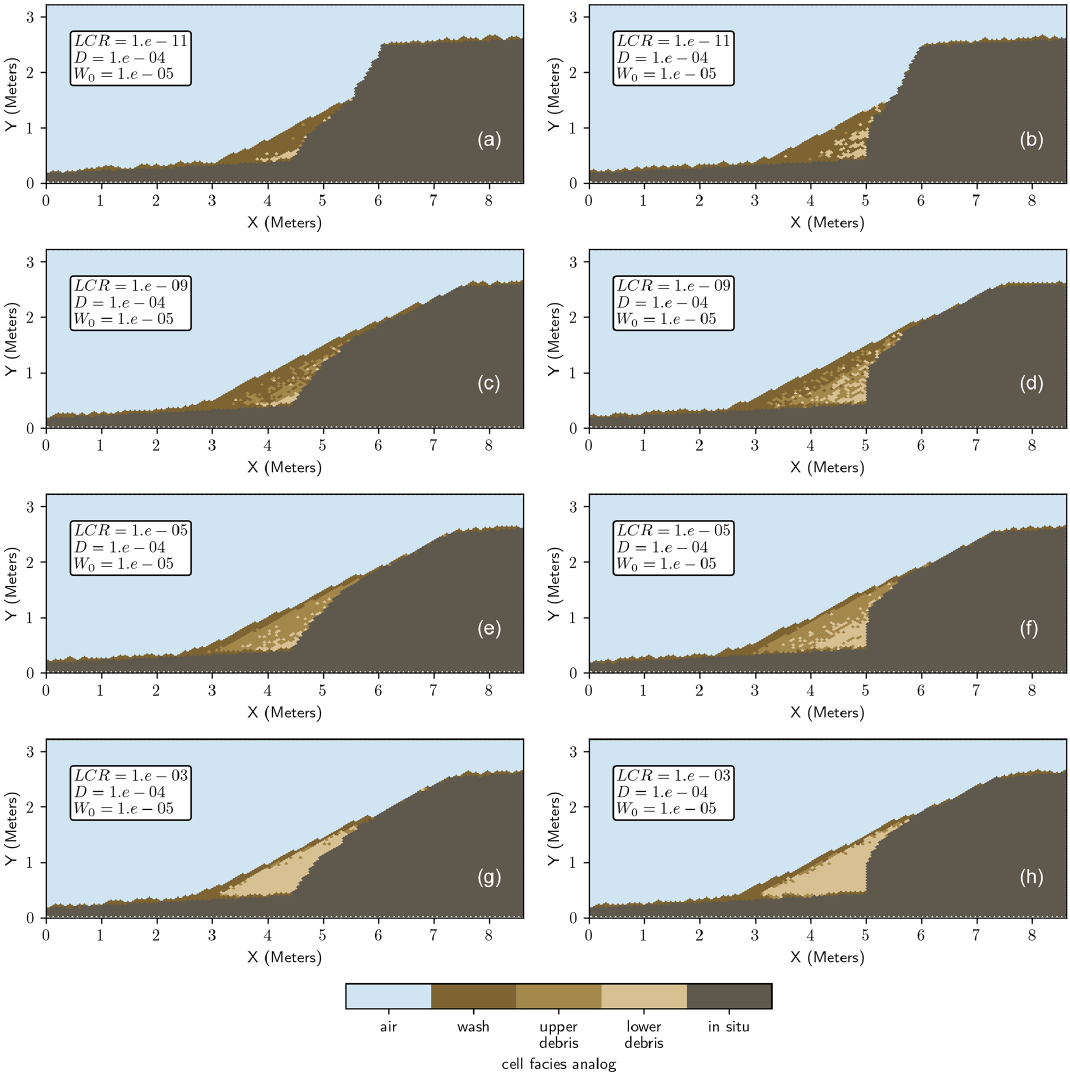
Figure 10. Example illustration of a modeled colluvial wedge with sediment facies analogs for 60 ◦ and vertical fault planes as a function of lateral collapse rate (LCR). The lateral collapse rate is taken as a fraction of gravity, e.g., LCR 1e-05 is a rate of 10 − 5 times gravity entered into the lateral collapse function (Fig. 3). Higher collapse rates generally promote larger colluvial wedges and larger volumes of debris facies versus wash facies for a given geomorphic process rates ( D , W 0